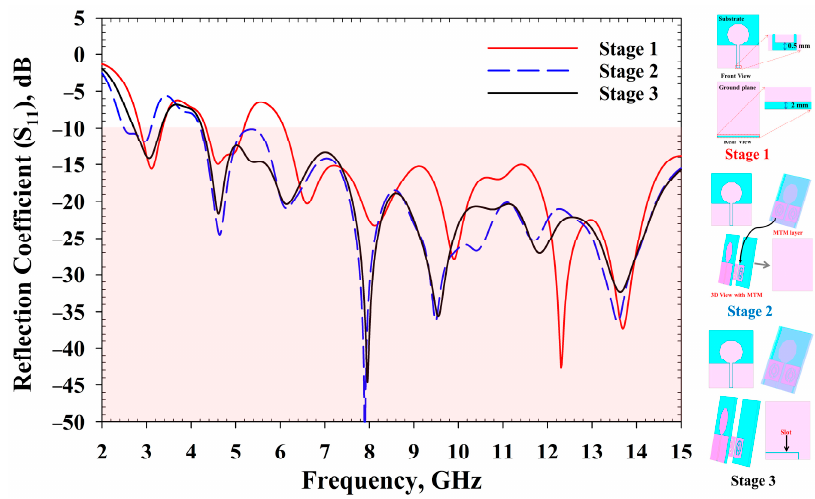
Figure 5. Effects of MTM and evolution of MBRU.